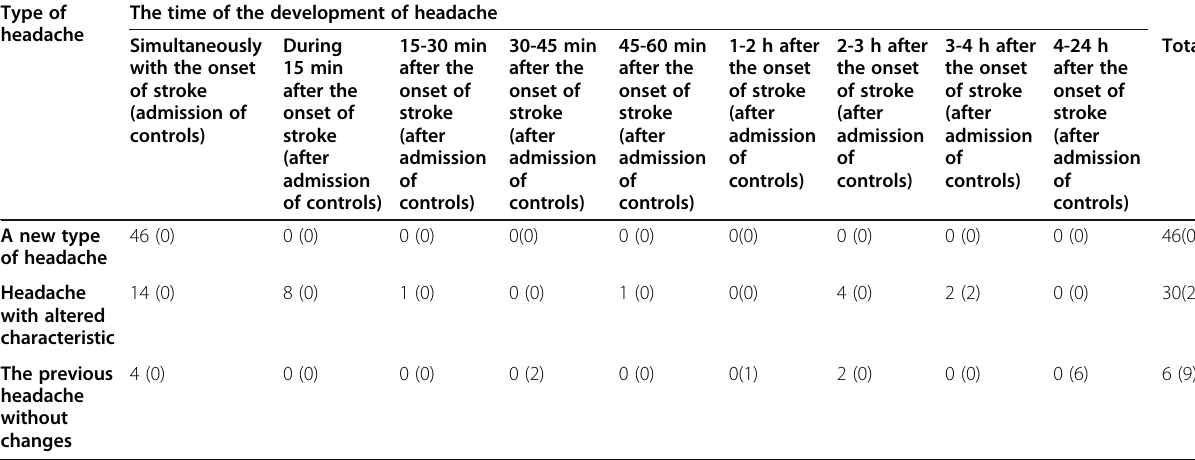
Table 2 The time of development of headache on the day of the onset of first-ever ischemic stroke or on the day of admission of controls (in